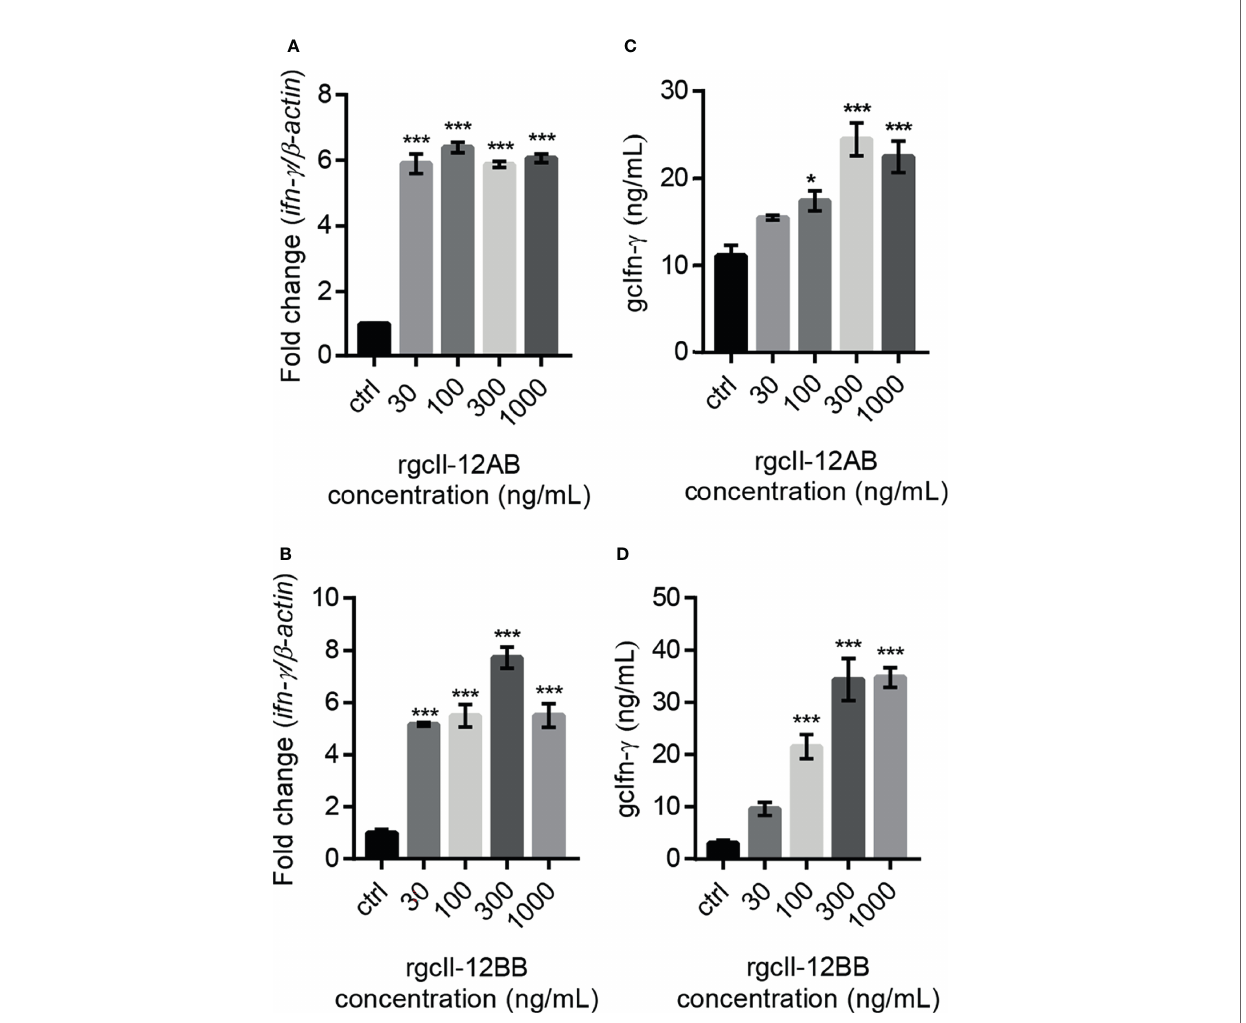
FIGURE 5 | Effects of rgcIl-12 isoforms on Ifn- g mRNA expression and protein release in grass carp HKLs. HKLs were treated with rgcIl-12AB or rgcIl-12BB (30- 1000 ng/mL) for 12 h (A, B) . The mRNA levels of ifn- g mRNA were detected by qPCR. The mRNA levels were normalized by b -actin and expressed as fold changes compared with the control group. The protein levels of gcIfn- g in HKLs culture medium were detected by competitive-inhibition ELISA after the HKLs were treated with rgcIl-12AB or rgcIl-12BB (30-1000 ng/mL) for 12 h (C, D) . Data are shown as mean ± SEM (N = 4). * p < 0.05 and *** p <